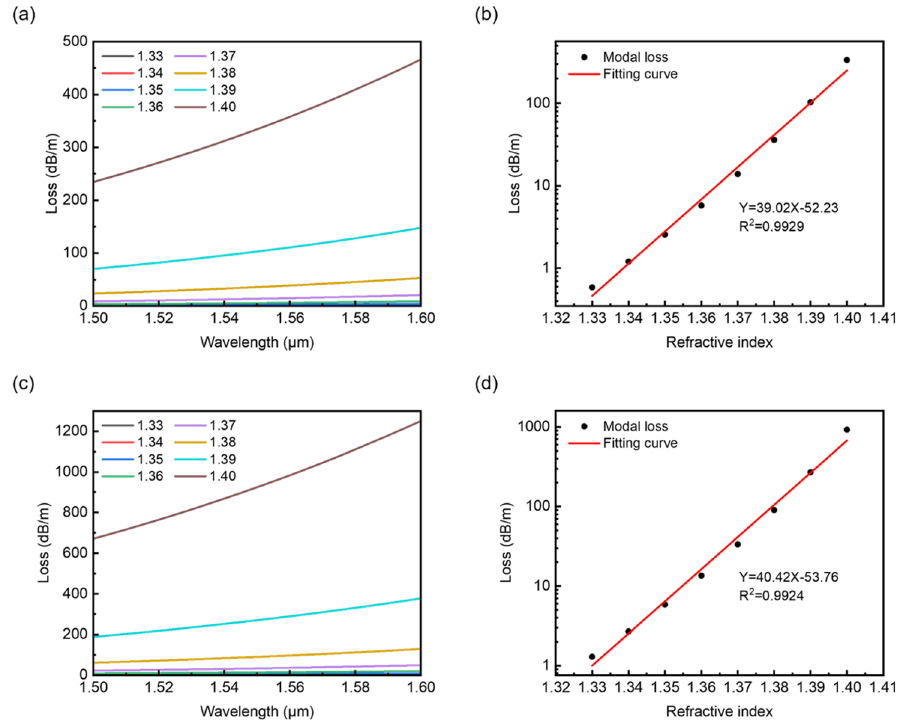
Figure 9. Confinement loss versus wavelength and the linear fitting for selected wavelength λ = 1.55 μ m with analyte refractive index changing from 1.33 to 1.40 for A = 20 cm − 1 ( a , b ) and 25 cm − 1 ( c , d ).